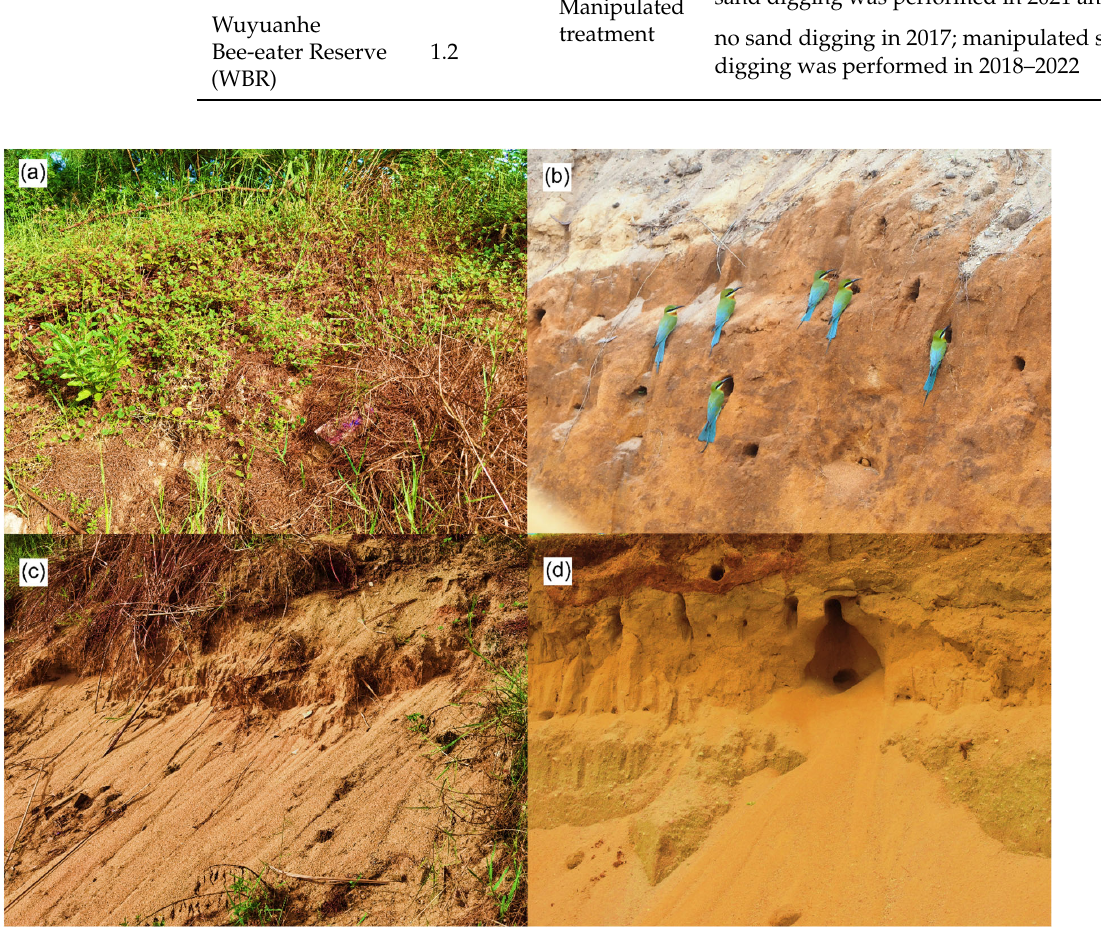
Figure 1. Different types of sand walls. ( a ) Before sand-digging activities, this sand wall was covered by vegetation, making it unsuitable for nesting by blue-tailed bee-eaters ( Merops philippinus ). ( b ) Sand digging resulted in a bare and vertical slope where bee-eaters could easily excavate breeding cavities. ( c ) After 1 or 2 years of abandonment and no sand digging, the sand wall became too loose for cave excavation due to rainwater and wind erosion. ( d ) A sand wall with bee-eater breeding cavities, destroyed by exploitative sand